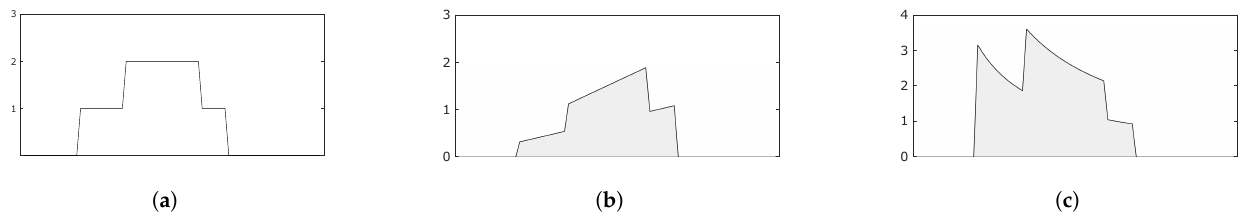
Figure 3. Accumulation of plantar pressure data from a sensor per step. ( a ) Plantar pressure of a sensor in one step. ( b ) Temporally increasing weighting accumulation. ( c ) Temporally decreasing weighting